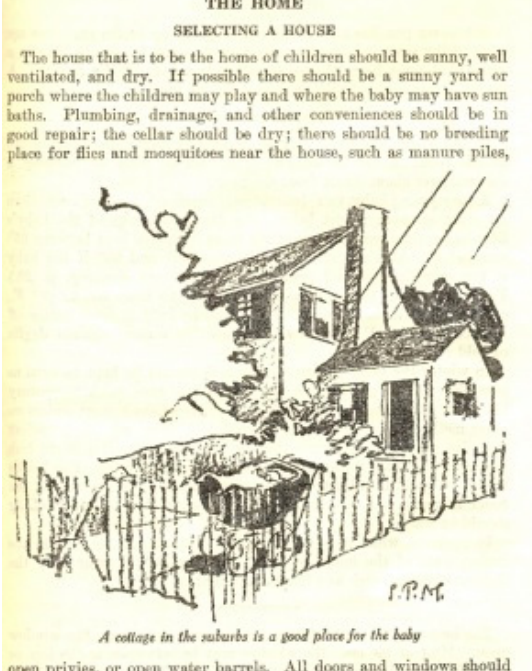
Figure 33. Advice on Choosing a Home.